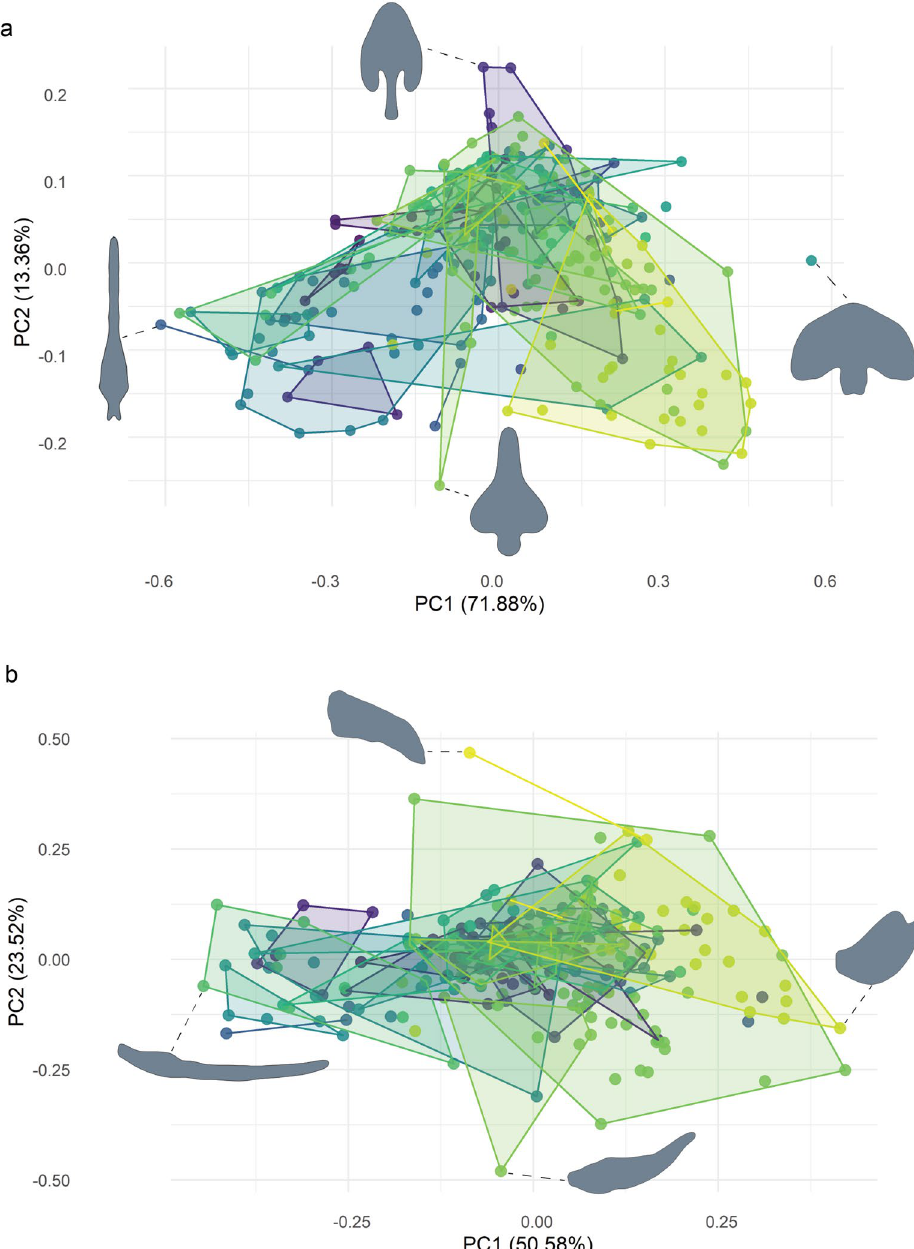
Figure 2. Morphospace plots based on male schizomid flagella, categorized by genus. ( a ) Dorsal view. PC1 extremes are Colombiazomus truncatus Armas and Delgado-Santa, 2012 (negative) and Kenyazomus pekkai Armas 2014 (positive). PC2 extremes are Schizomus procerus (Hansen in Hansen and Sörensen, 1905) (negative) and Bamazomus subsolanus Harvey, 2001 (positive). ( b ) Lateral view. PC1 extremes are Piaroa virichaj Villarreal, Giupponi and Tourinho, 2008 (negative) and Rowlandius ramosi Armas, 2002 (positive). PC2 extremes are Schizomus hanseni Mello-Leitão, 1931 (negative) and Troglocubazomus inexpectatus Teruel and Rodríguez- Cabrera, 2019